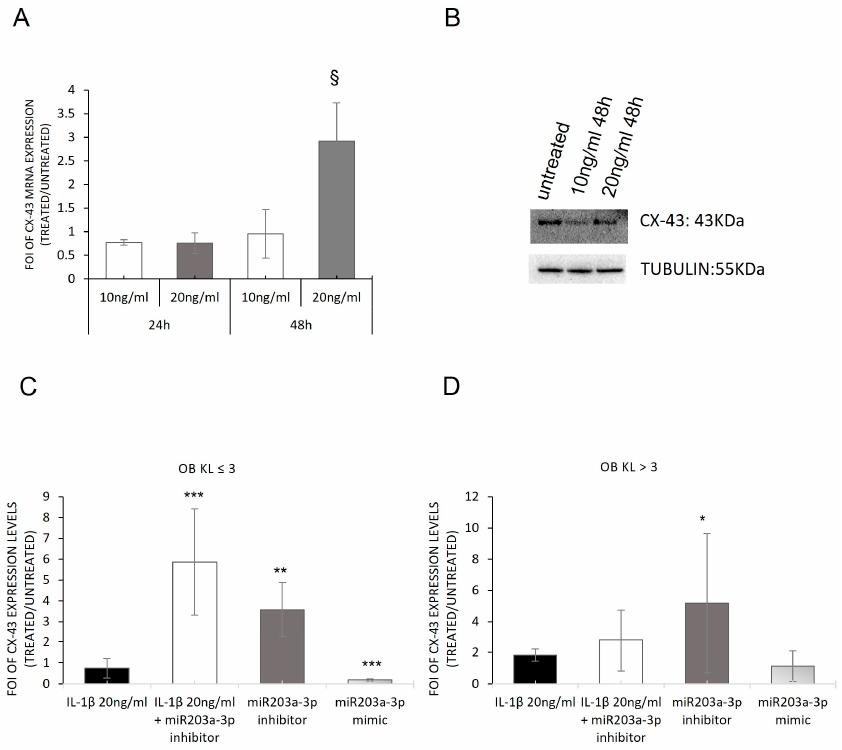
Figure 6. Involvement of IL-1 β in CX-43 expression on treated hMSCs and osteoblasts derived from OA patients. qRT-PCR analysis of CX-43 mRNA expression on hMSCs treated with IL-1 β (10 ng/mL and 20 ng/mL) for 24 h and 48 h ( A ) and OB-OA-derived KL ≤ 3 ( C ) and KL > 3 ( D ) groups treated with IL-1 β , miR203a-3p inhibitor, and miR203a-3p mimic or after co-treatments with IL-1 β and miR203a-3p inhibitor. Data are expressed as fold of induction (FOI) in gene expression (2 −ΔΔ Ct ) occurring in treated vs. scrambled untreated groups (mean ± SD, n = 4). Two-way (treatment and experimental time interaction for hMSC: F = 3.70, p = 0.045) and one-way ANOVA (KL ≤ 3: F = 42.75 p < 0.0005; KL > 3: F = 2.17, NS ); multiple comparisons (one symbol, p < 0.05; two symbols, p < 0.005; three symbols, p < 0.0005)versus : *, OBs ; § , hMSCs untreated 48h. Western blot of CX-43 and tubulin expression on hMSCs treated with IL-1 β (10 ng/mL and 20 ng/mL) for 48 h ( B ).